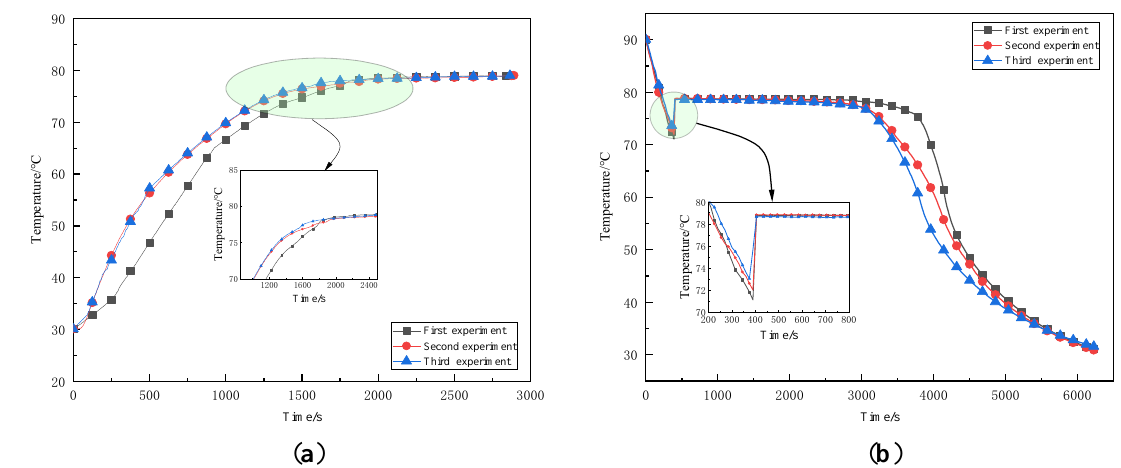
Figure 2. ( a ) Base material Ba(OH) 2 · 8H 2 O heat curve; ( b ) base material Ba(OH) 2 · 8H 2 O exothermcurve.